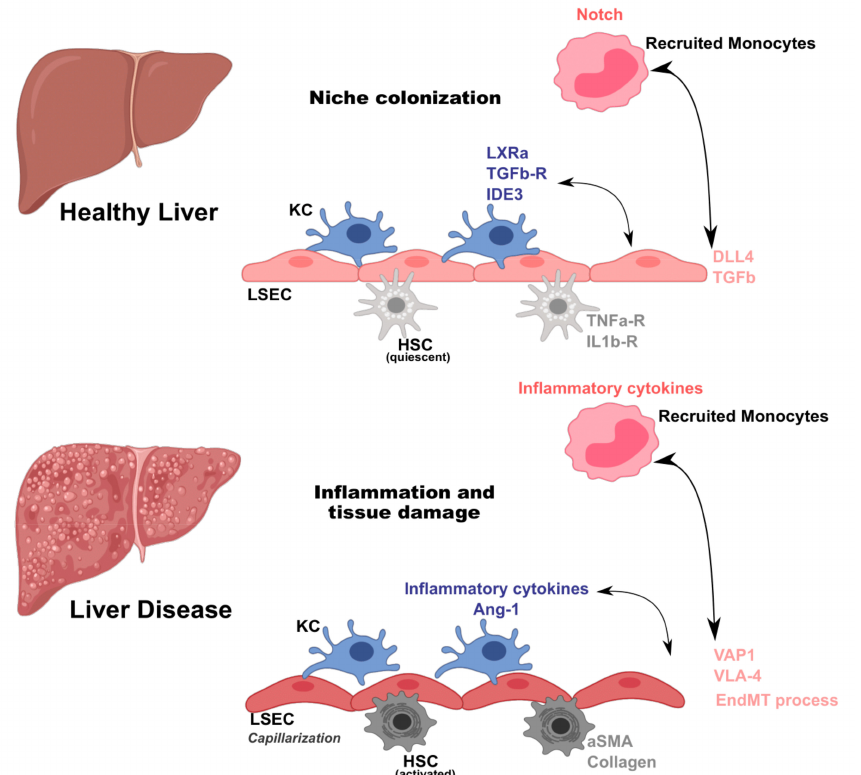
Figure 1. Macrophage and endothelial cell crosstalk in homeostasis and liver disease. Liver cell interactions occur by tightly regulated mechanisms. In homeostatic conditions, perturbations in the Kupffer cell (KC) niche induce recruitment of monocytes. Once in the liver, monocytes receive signals from liver sinusoidal endothelial cells (LSEC) such as delta like canonical notch ligand 4 (DLL4) and transforming growth factor beta (TGFb), and from hepatic stellate cells (HSC) through TNFa-R and interleukin receptor 1 receptor (IL1b-R), that result in acquisition of KC-specific transcriptional program (expression of liver X receptor alpha (LXRa), transforming growth factor beta (TGFb-R), and inhibitor of DNA binding 3 (IDE3)). During liver disease, macrophages and endothelial cells are activated and their interactions amplify inflammation and tissue damage. Macrophages secrete inflammatory cytokines and chemokines and growth factors (Ang-1), while endothelial cells increase expression of adhesion molecules (vascular adhesion protein 1-VAP1 and integrin alpha-4 subunit- VLA-4). Moreover, infiltrating macrophages induce endothelial to mesenchymal transition (EndMT) on endothelial cells, a key process for fibrosis induction and establishment in liver pathology, and hepatic stellate cell (HSC) activation that secrete α -smooth muscle actin ( α -SMA) and